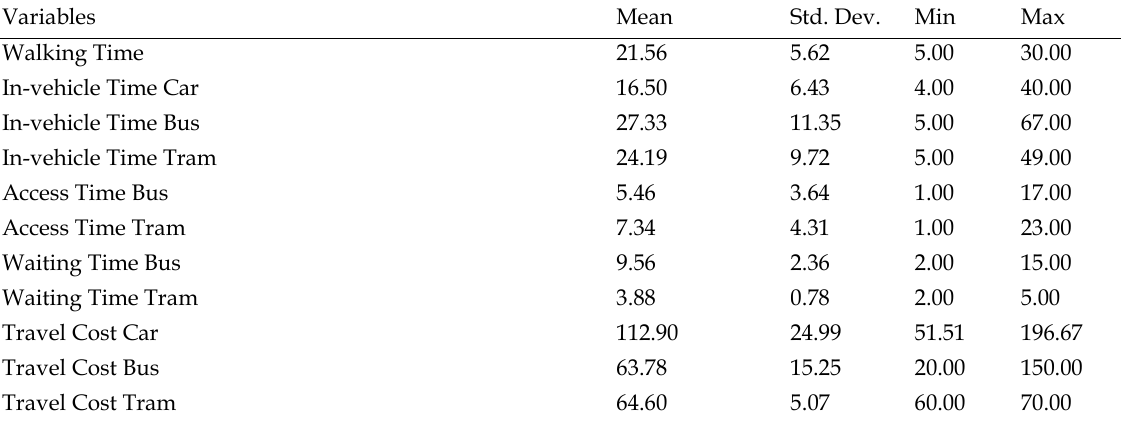
Table 4. Reported and simulated travel